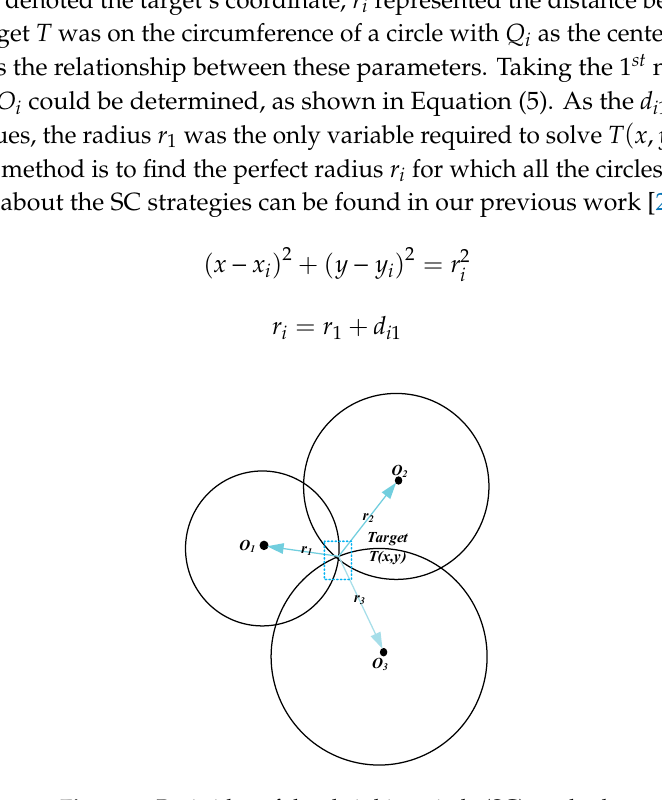
Figure 6. Diagram of positioning correction.